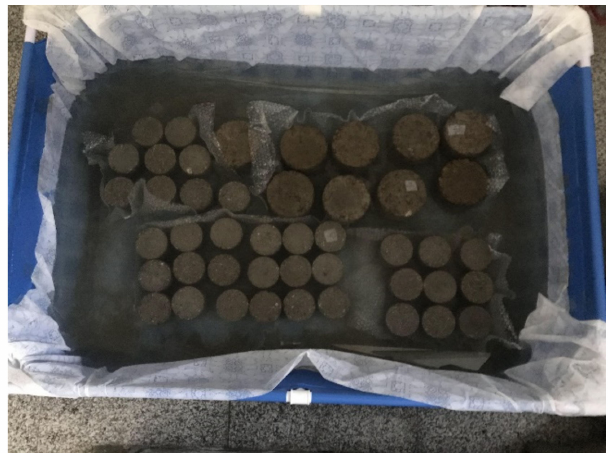
Figure 4. Sample